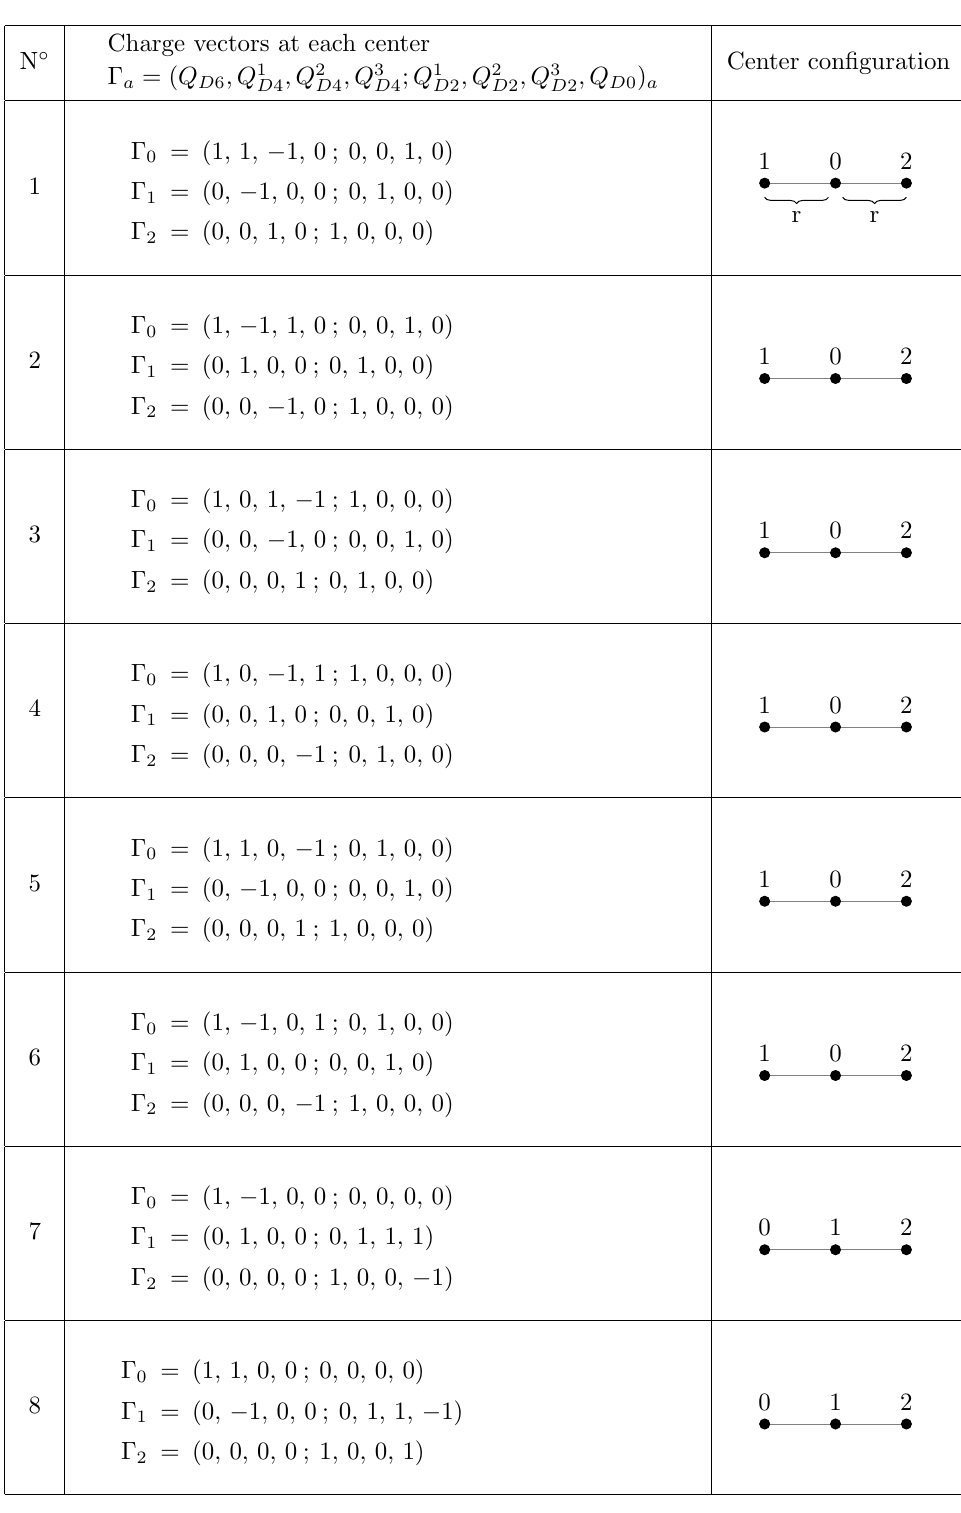
The 12 multicenter solutions with global D-brane charges ( Q D 6 ; Q 1